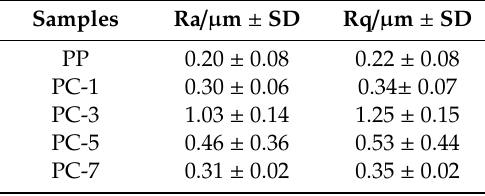
Table 4. Roughness parameters of the investigated samples ( R a –average roughness, R q –root mean square).